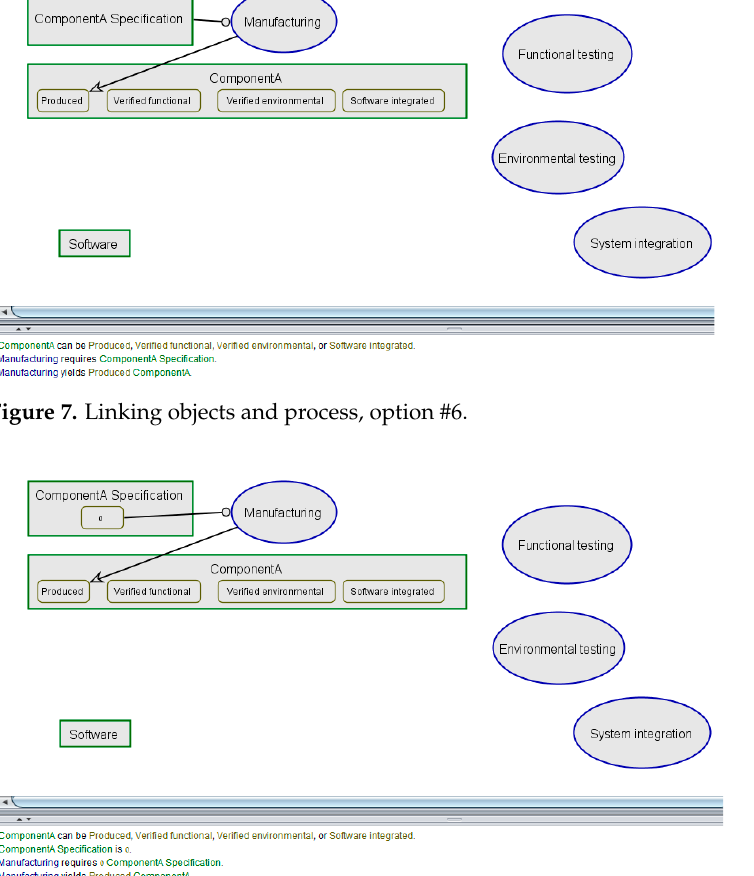
Figure 8. Linking objects and process, option #7.